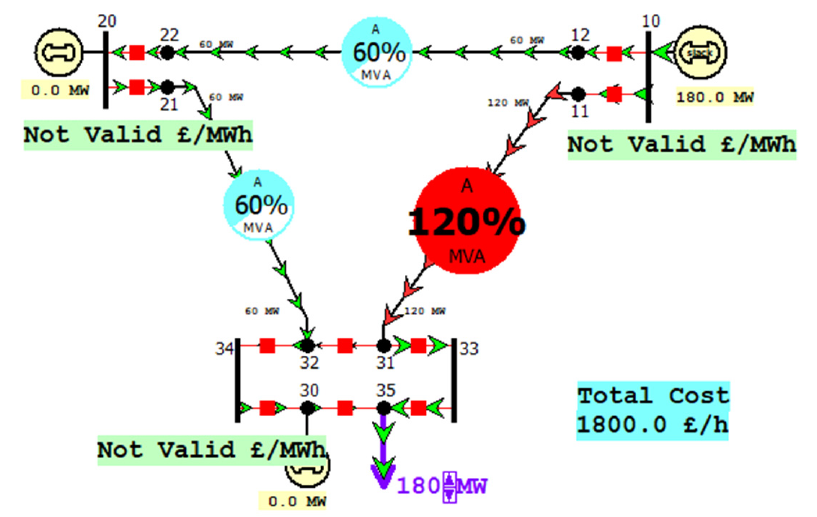
Figure 5. Attack scenario when a generator is tripped.